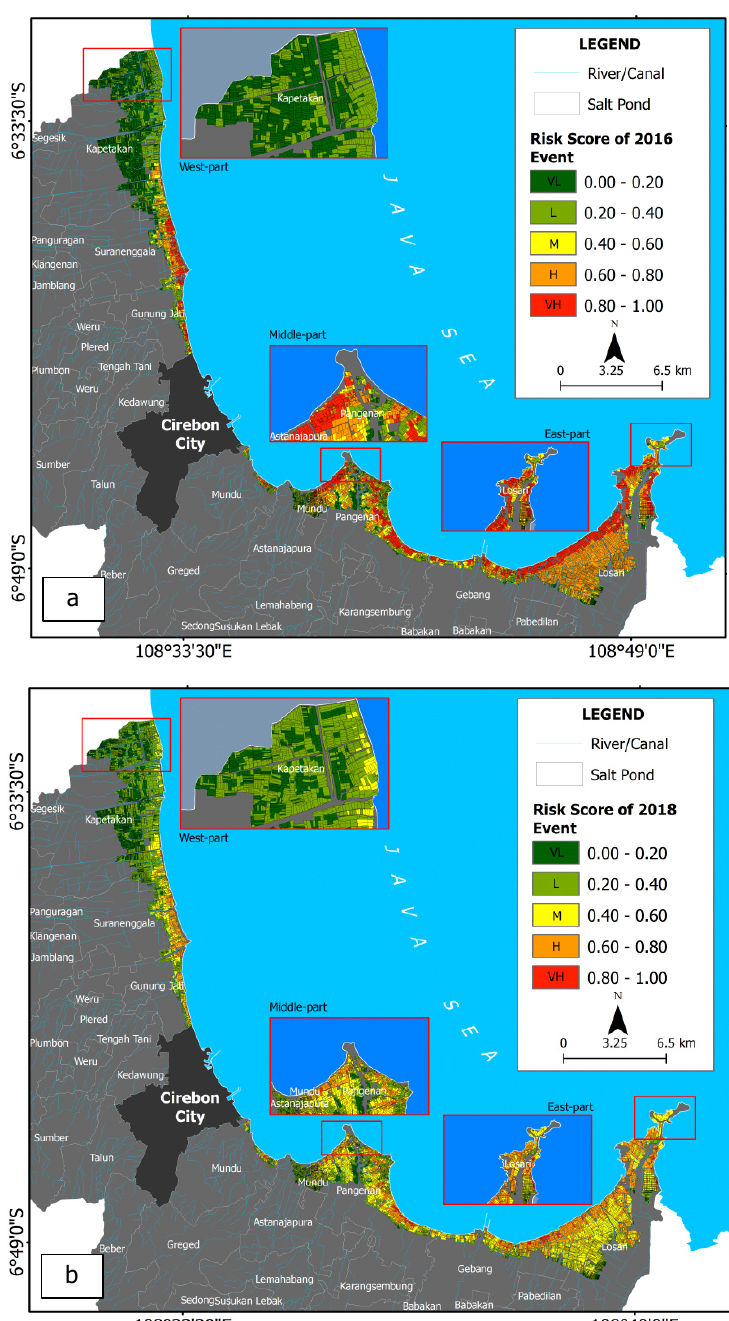
Figure 7. Tidal flood risk on salt farming land in Cirebon, West Java, based on the evaluation of the 2016 ( a ) and 2018 ( b ) events.